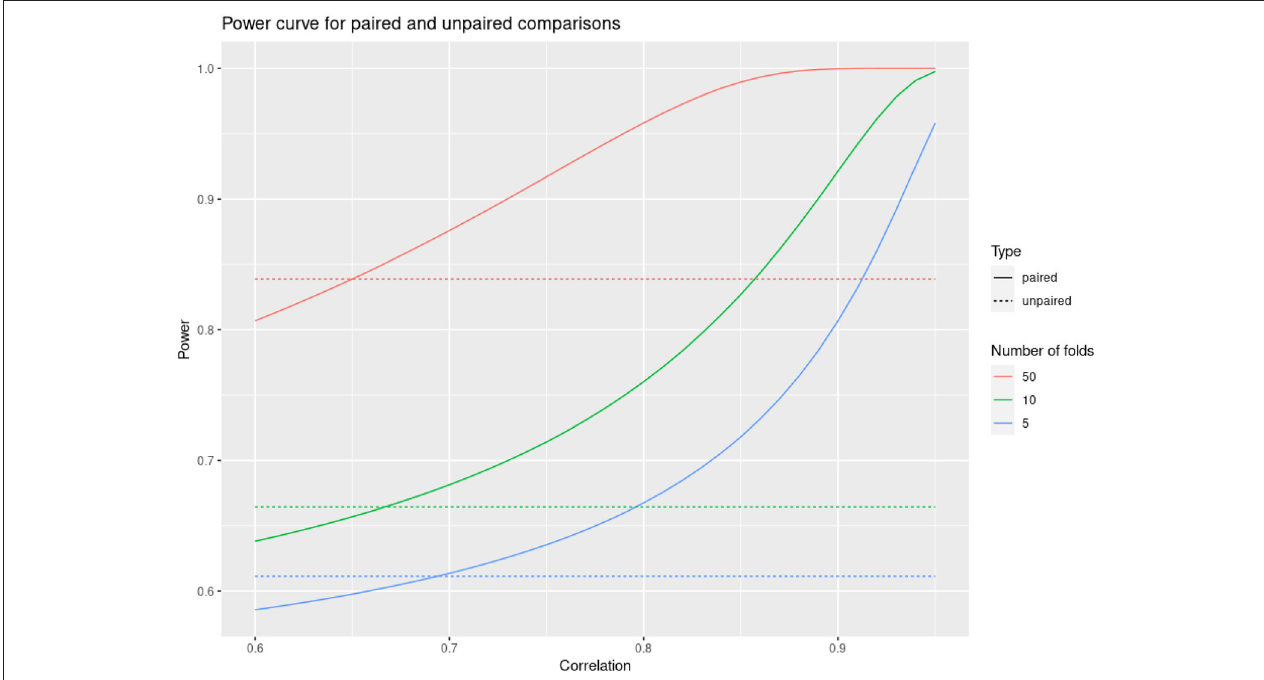
FIGURE 1 | Power curve for paired and unpaired cross validations as a function of fold correlation between compared